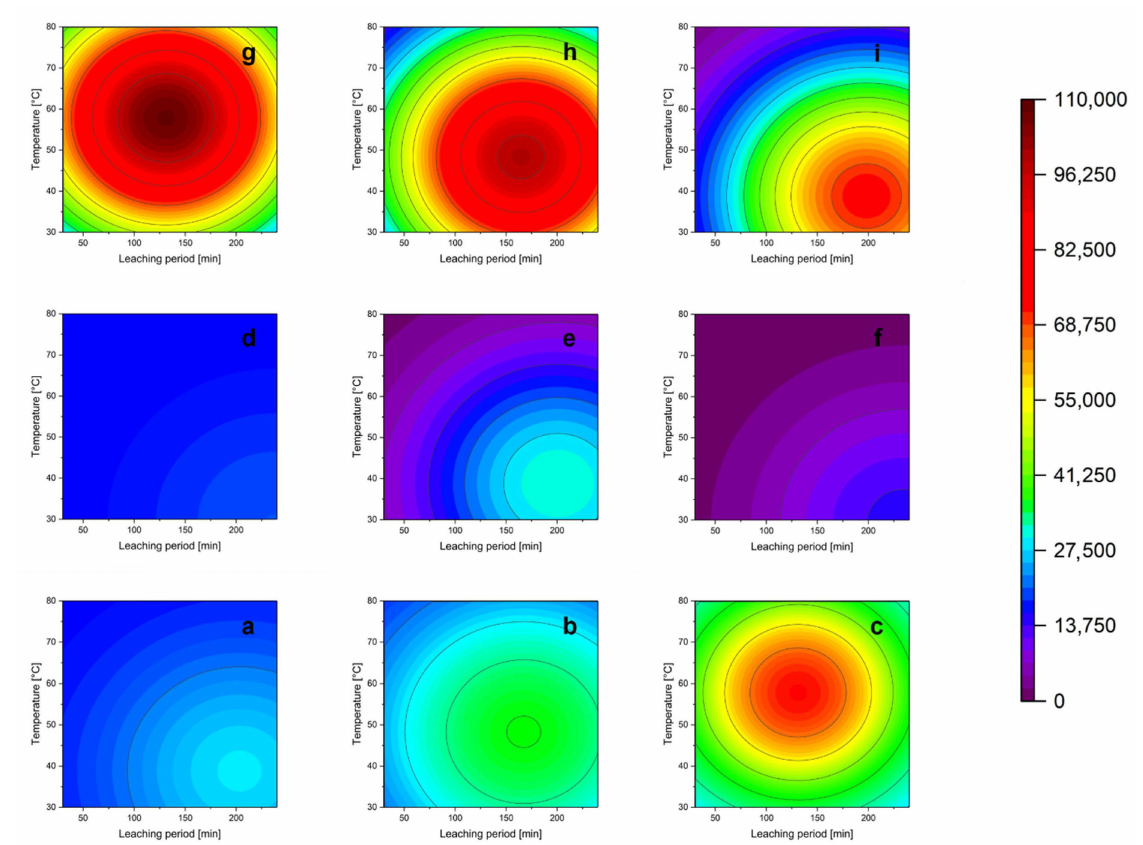
Figure 6. Statistical evaluation of the iron content in mg · L − 1 for an S/L ratio of 100 g · L − 1 as a function of temperature, leaching time, acid, and oxidizing agent concentration (( a ): 0.3 MH 2 SO 4 , 0 vol% H 2 O 2 , ( b ): 0.3 MH 2 SO 4 , 7.5 vol% H 2 O 2 , ( c ): 0.3 MH 2 SO 4 , 15 vol% H 2 O 2 , ( d ): 1.15 MH 2 SO 4 , 0 vol% H 2 O 2 , ( e ): 1.15 MH 2 SO 4 , 7.5 vol% H 2 O 2 ; ( f ): 1.15 MH 2 SO 4 , 15 vol% H 2 O 2 , ( g ): 2 MH 2 SO 4 , 0 vol% H 2 O 2 , ( h ): 2 MH 2 SO 4 , 7.5 vol% H 2 O 2 , ( i ): 2 MH 2 SO 4 , 15 vol% H 2 O 2